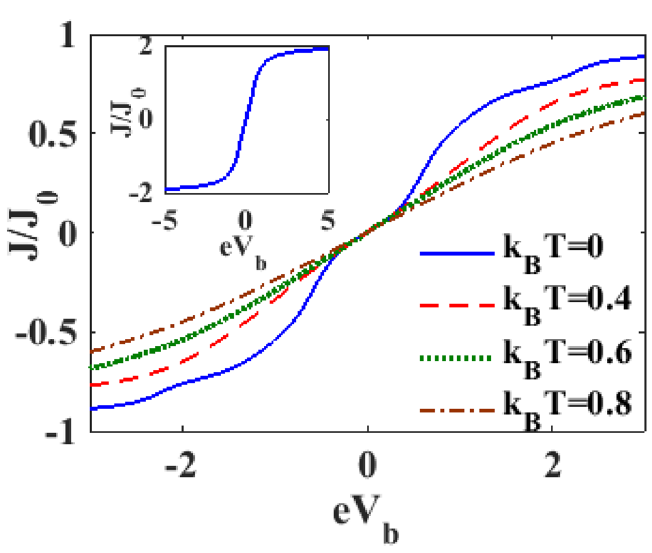
Figure 6. J / J 0 versus eV b for different values of k B T at (cid:31) = 0.6, eV m = 0.5, γ = 0.02